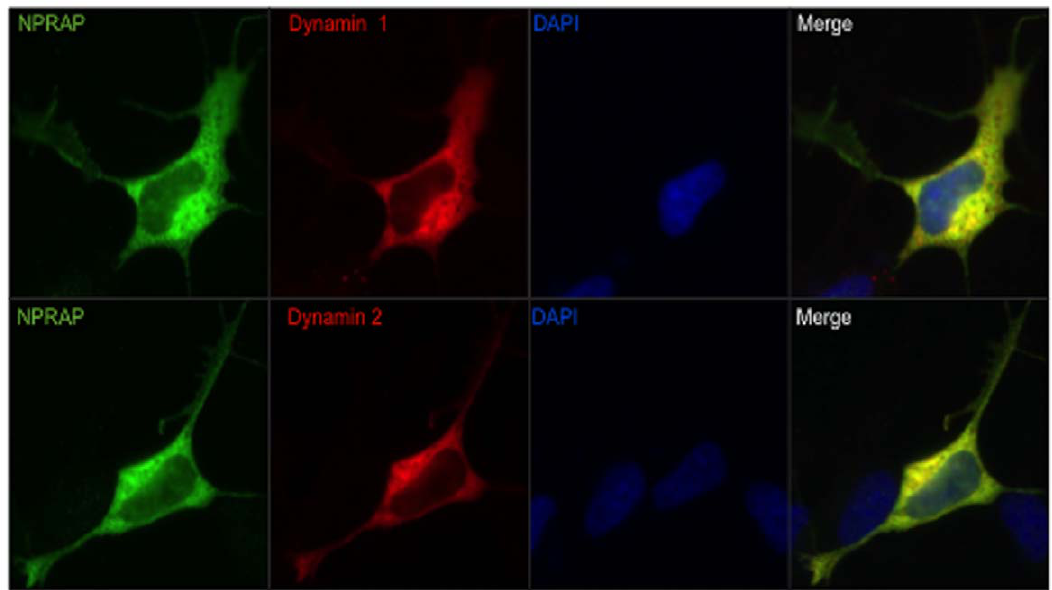
Figure 2. Dynamins colocalize with NPRAP. Immunolabeling studies showed that NPRAP and dynamin 1 or 2 colocalized in the perykarion of SH SY5Y cells. Note that this pattern seemed restricted to the cell body because the protrusions were labeled for NPRAP only, whereas a weak signal or lack of signal was observed for either dynamin 1 or 2 in those compartments. Images represent at least three independent experiments with similar immunofluorescent pattern results.